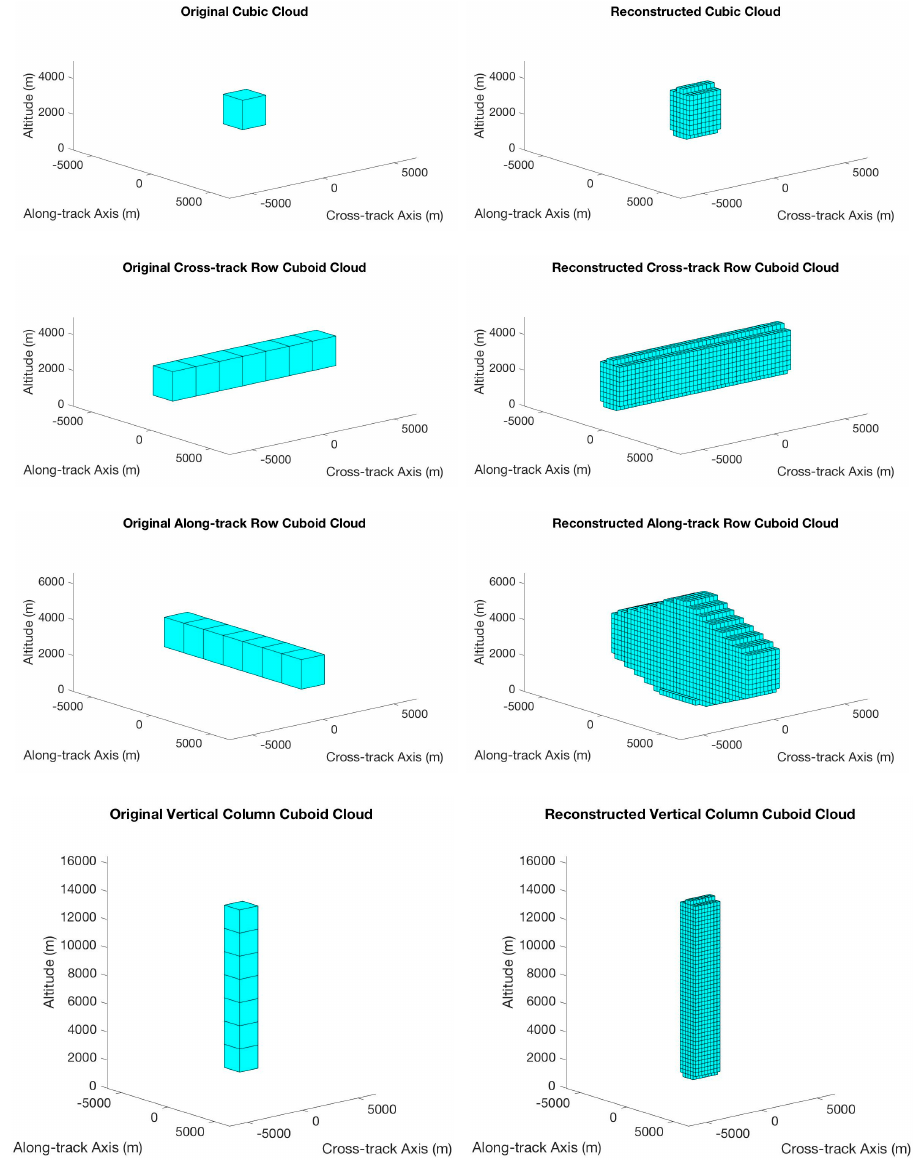
Figure 2. An example comparison between the original (left images) and the reconstructed (right images) cloud volumes. From top to bottom: Cubic cloud, cross-track row cuboid cloud, along-track row cuboid cloud, and vertical column cuboid cloud. In this example, the lengths of all the original cuboid clouds are 7 × 1650 m = 11550 m. The reconstruction voxel grid resolution is 275 m. All plots are to